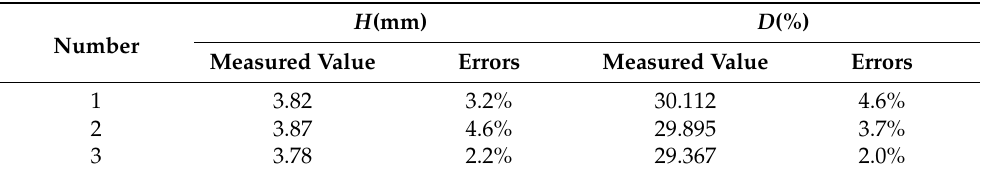
Table 6. Experimental verification results.